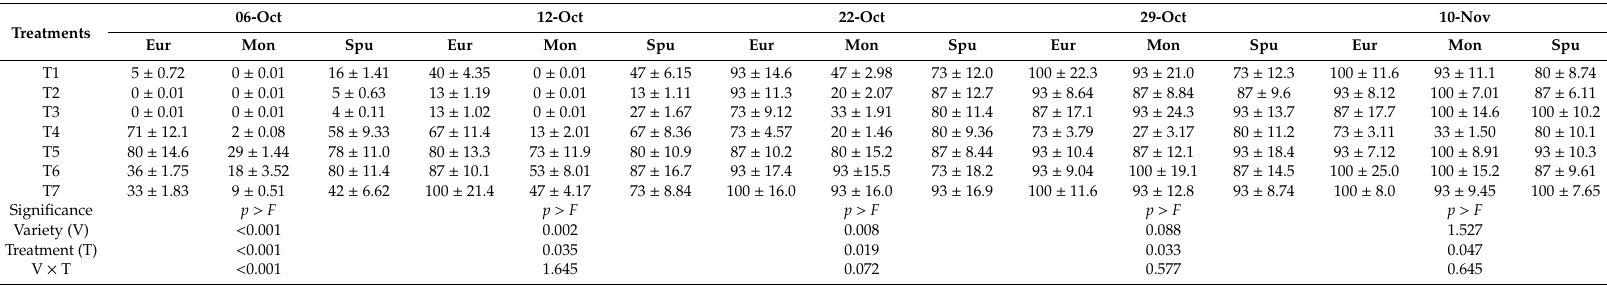
Table 6. Average ( ± standard error) percentage of plant emergence (%) in open-field condition for three varieties (Europa, Monalisa and Spunta) subjected to seven pre-planting dormancy-breaking treatments and accross di ff erent monitoring dates (Experiment 1).